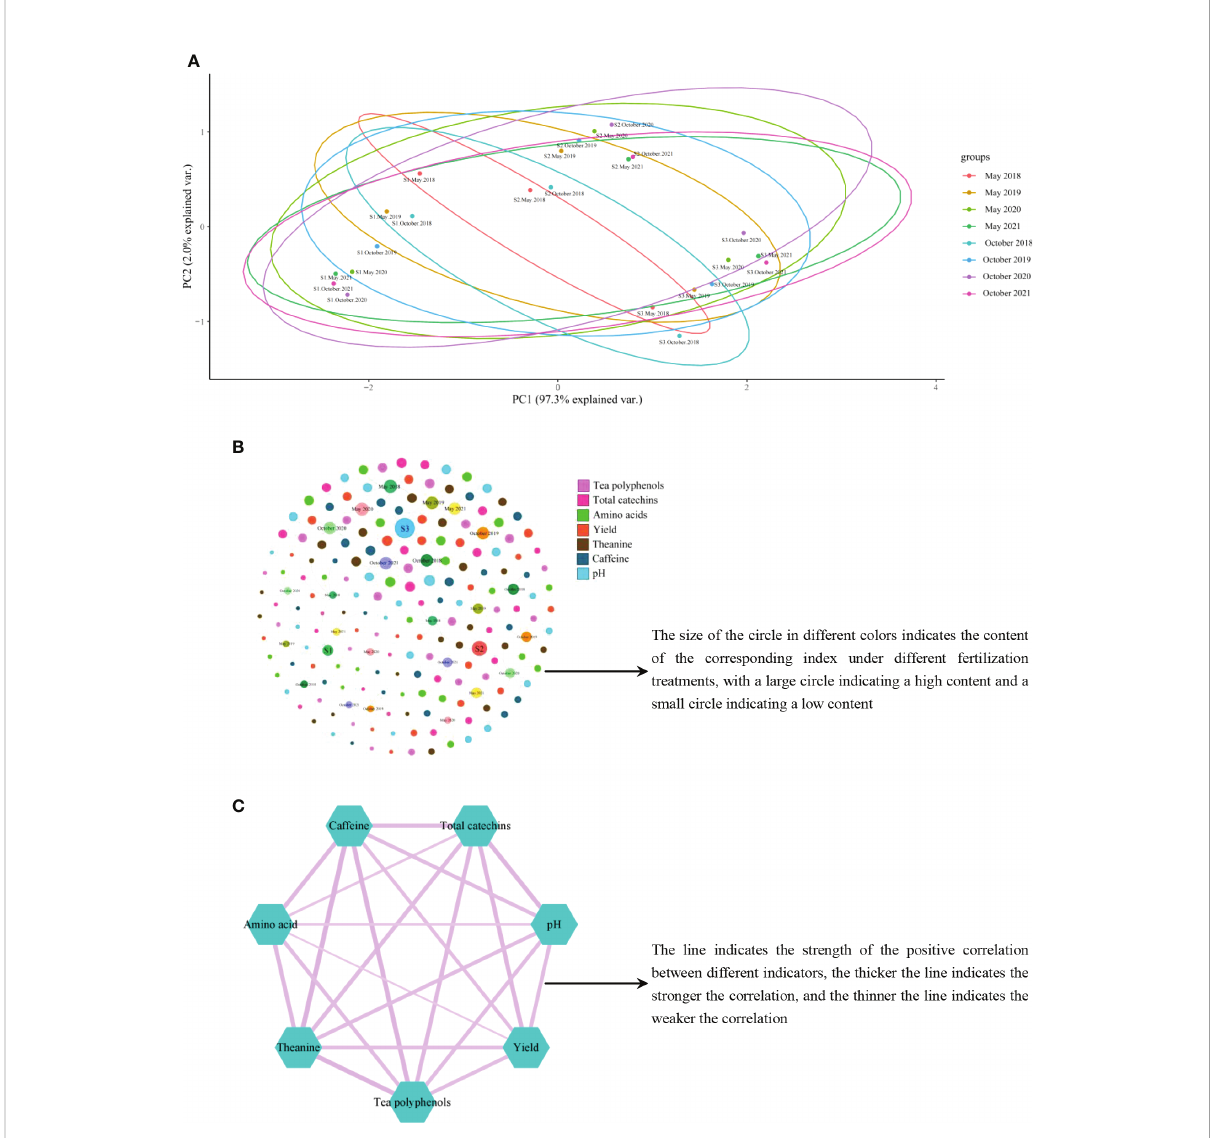
FIGURE 6 Interactions among soil pH, tea yield and quality indexes after different fertilization treatments. S1: 100% Chemical fertilizer; S2:50% Organic fertilizer +50% chemical fertilizer; S3: 100% Organic fertilizer; (A) Principal component analysis of samples from different years after different fertilization treatments; (B) Relationship network analysis of all measured indexes in different year samples after different fertilization treatments; (C) Correlation analysis of all measured indexes in different year samples after different fertilization